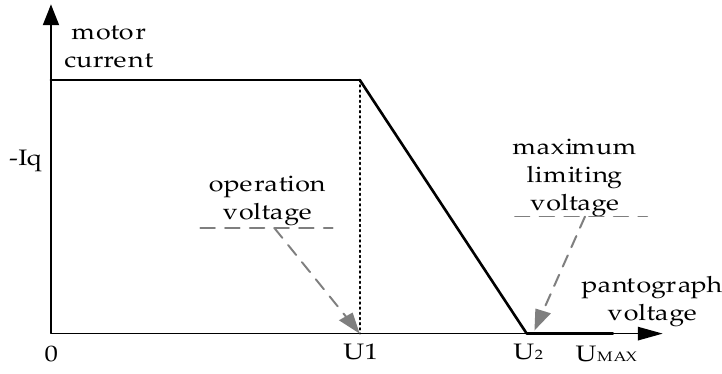
Figure 3. Squeezing curve of regenerative braking.